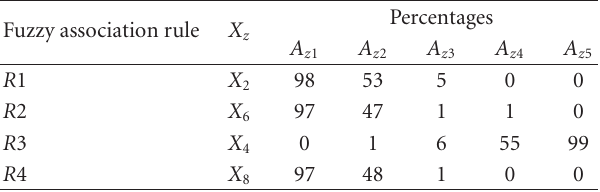
Table 5: Percentages of the confidence index for the fuzzy association rules.